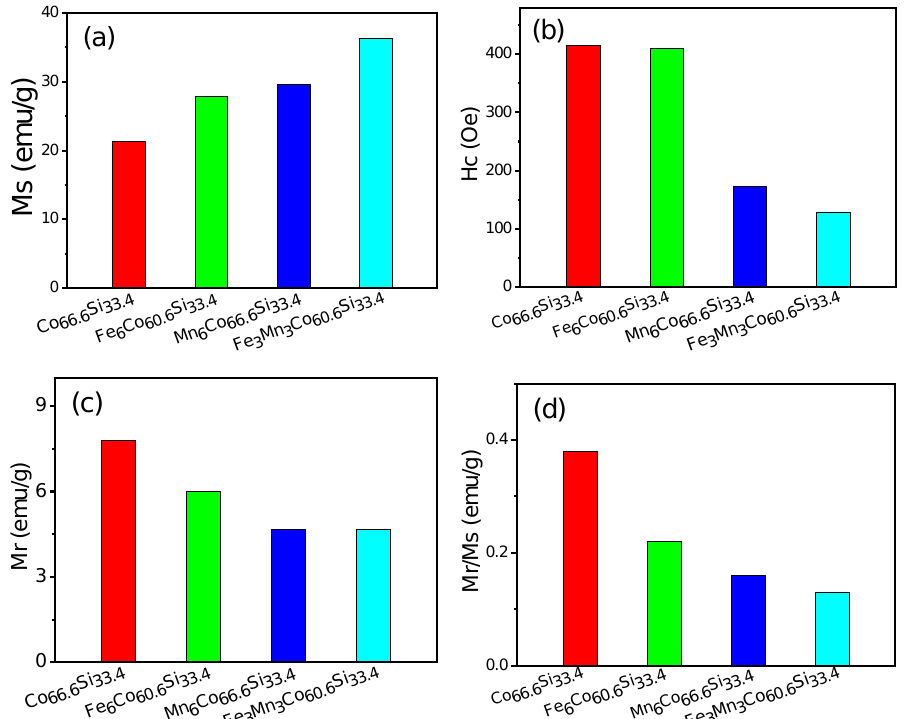
Figure 5. M s , H c and M r /M s of as-prepared Co 66.6 Si 33.4 , Co 60.6 X 6 Si 33.4 , (X = Fe, Mn), Co 60.6 Fe 3 Mn 3 Si 33.4